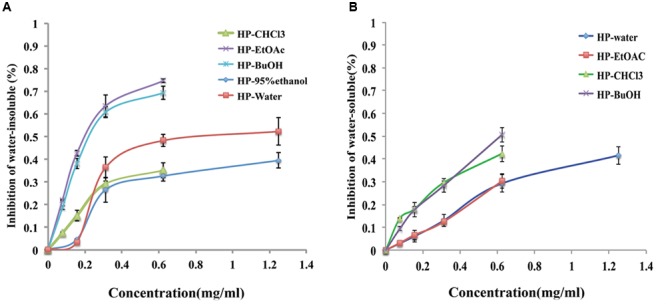
Percent inhibition of extracts/sub-extracts effect on EPS glucans by the phenol/H2SO4 method. (A) (%) Inhibition of water-insoluble glucans. (B) (%) Inhibition of water-soluble glucans. The extracts of B. crassifolia leaves were serially diluted twofold in BHI broth containing 1% sucrose from 1/8 MIC to MIC respectively. The graph represents the actual concentrations of the MIC dilutions. Data are presented as the mean ± standard deviation.